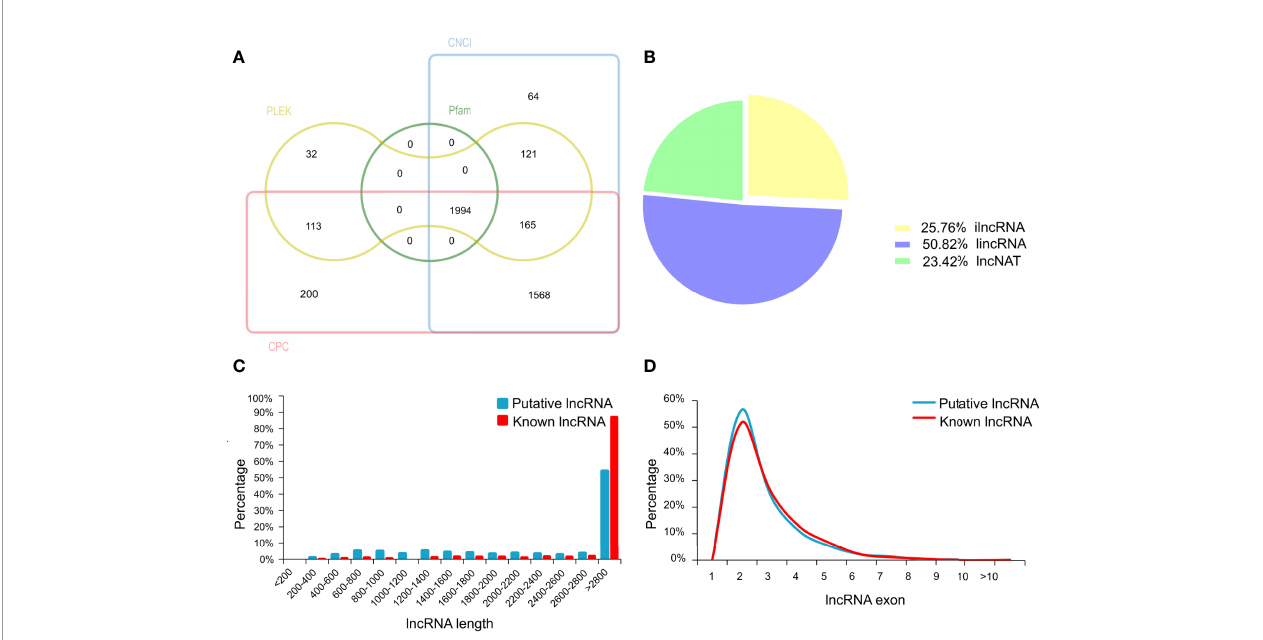
FIGURE 2 | The identi fi cation of long non-coding RNAs (lncRNAs) in chicken ovary. (A) Venn diagram analysis showing the number of common and unique novel lncRNAs identi fi ed by CNCI, CPC, PLEK and Pfam database. (B) Classi fi cation of the uniquely mapped read locations including exon, intron and intergenic regions. ilncRNA, intergenic lncRNA; lincRNA, intron lncRNA; lncNAT, antisense lncRNA. (C) Length of known and novel lncRNAs. (D) The percentage of exon number for known and novel